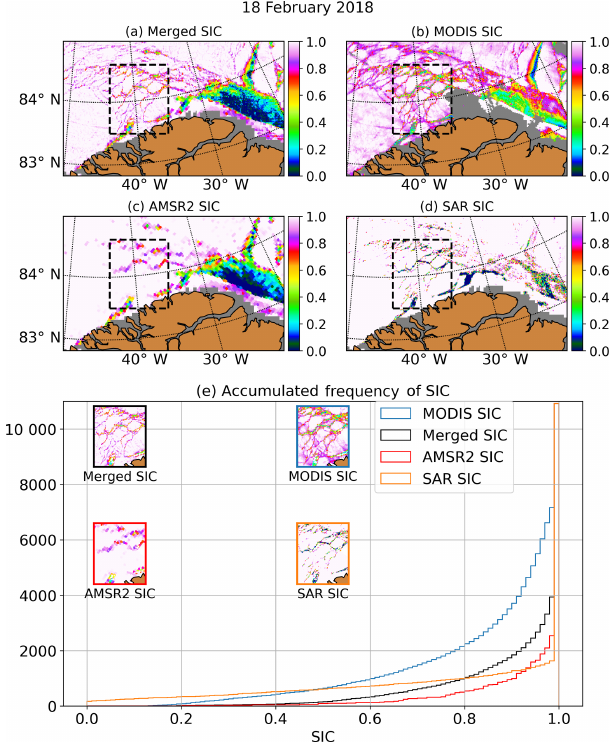
Figure 2. SIC on 18 February 2018 observed with (a) merged, (b) MODIS, (c) AMSR2 and (d) SAR SIC. The acquisition times for MODIS–AMSR2 were 11:45 and 11:39UTC, respectively. The dashed black box in panels (a) – (d) marks the region used in panel (e) . (e) Cumulative histograms for the four datasets. The in- sets show the SIC distribution for the single datasets. Data points for which one of the products was not available were discarded for all